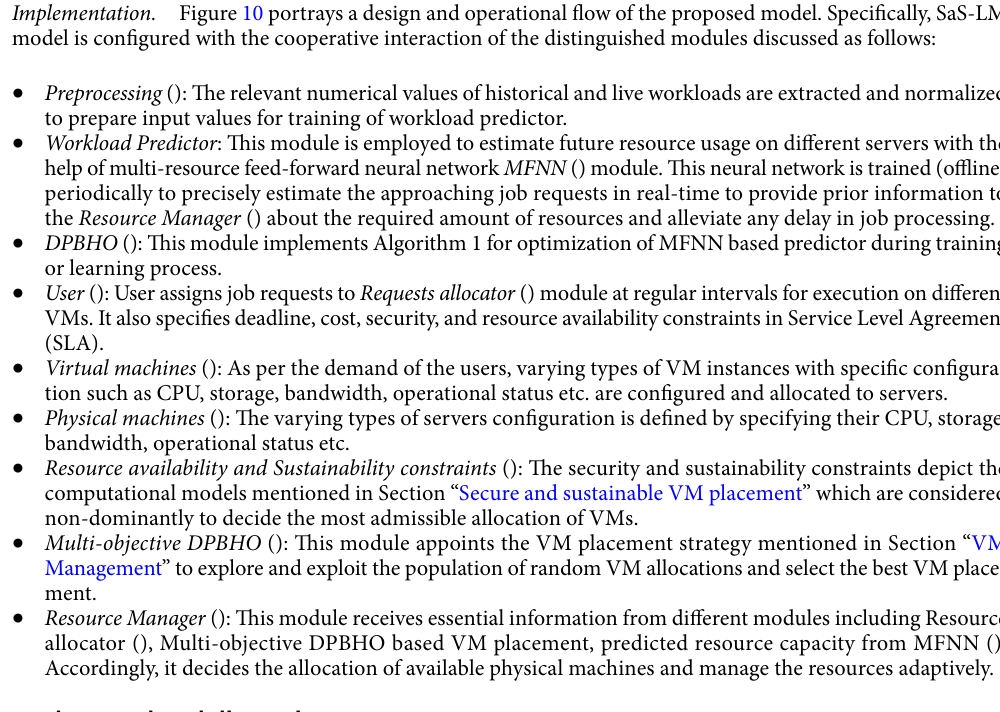
Implementation. Figure 10 portrays a design and operational flow of the proposed model. Specifically, SaS-LM model is configured with the cooperative interaction of the distinguished modules discussed as follows: